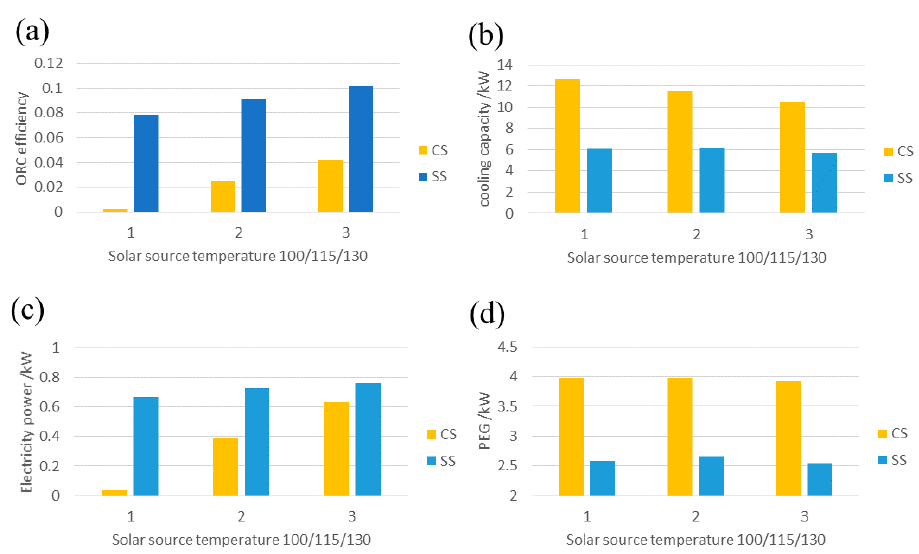
Figure 3. ( a ) ORC e ffi ciency, ( b ) cooling output capacity, ( c ) electricity generation and ( d ) primary energy e ffi ciency for the combined cooling, heating and power (CCHP) systems under di ff erent solar collecting temperature with R123 as ORC working fluids in cooling